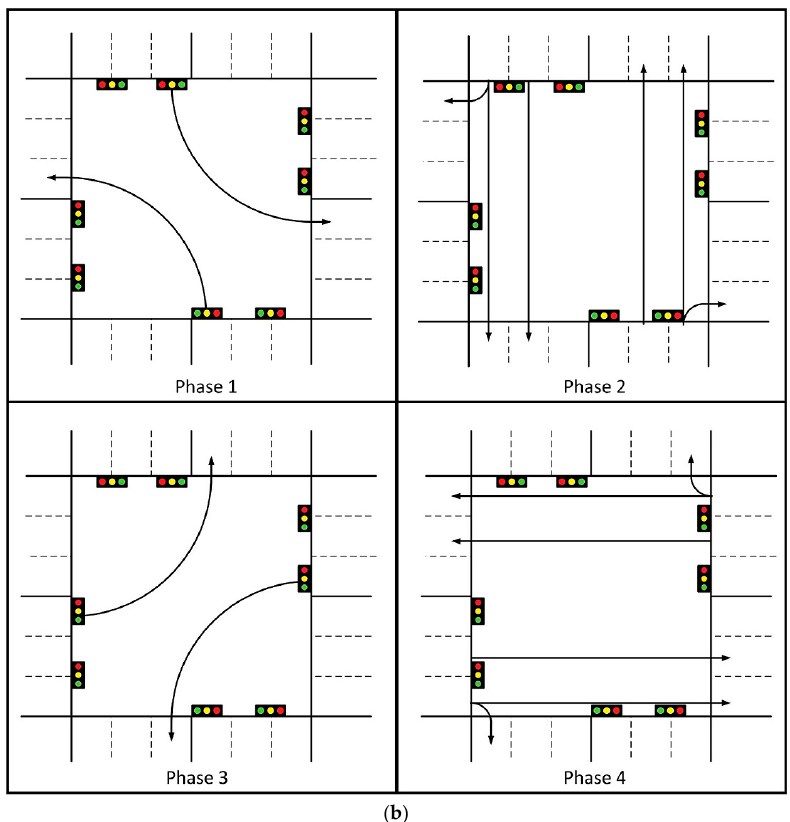
Figure 24. Traffic phases of the traffic light system of ( a ) Scenario 1: when all UAVs move straight and ( b ) Scenario 2: when UAVs can turn left, move straight, or turn right.